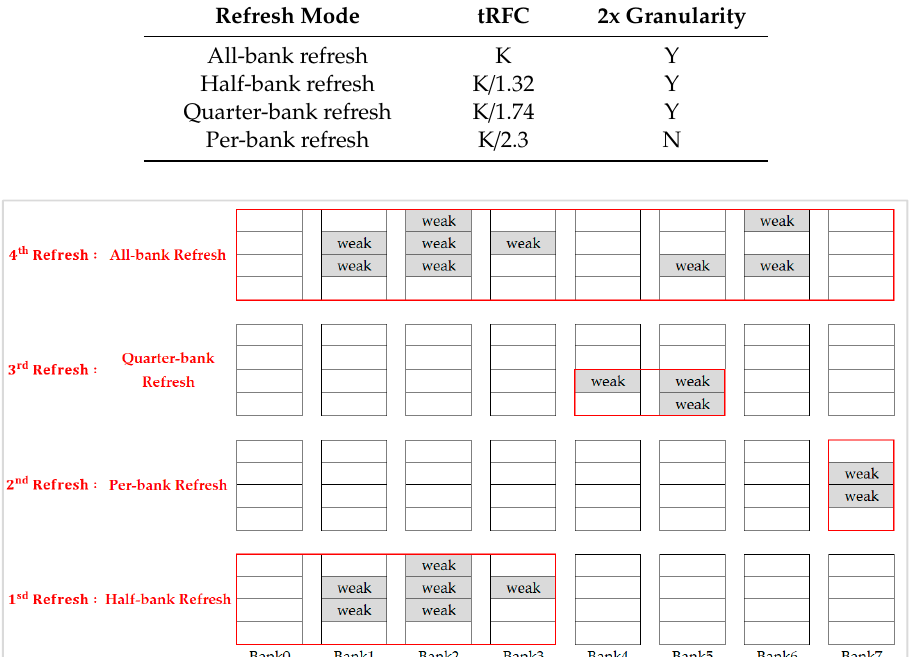
Table 2. Refresh cycle time (tRFC) parameters definition and 2x granularity refresh check.